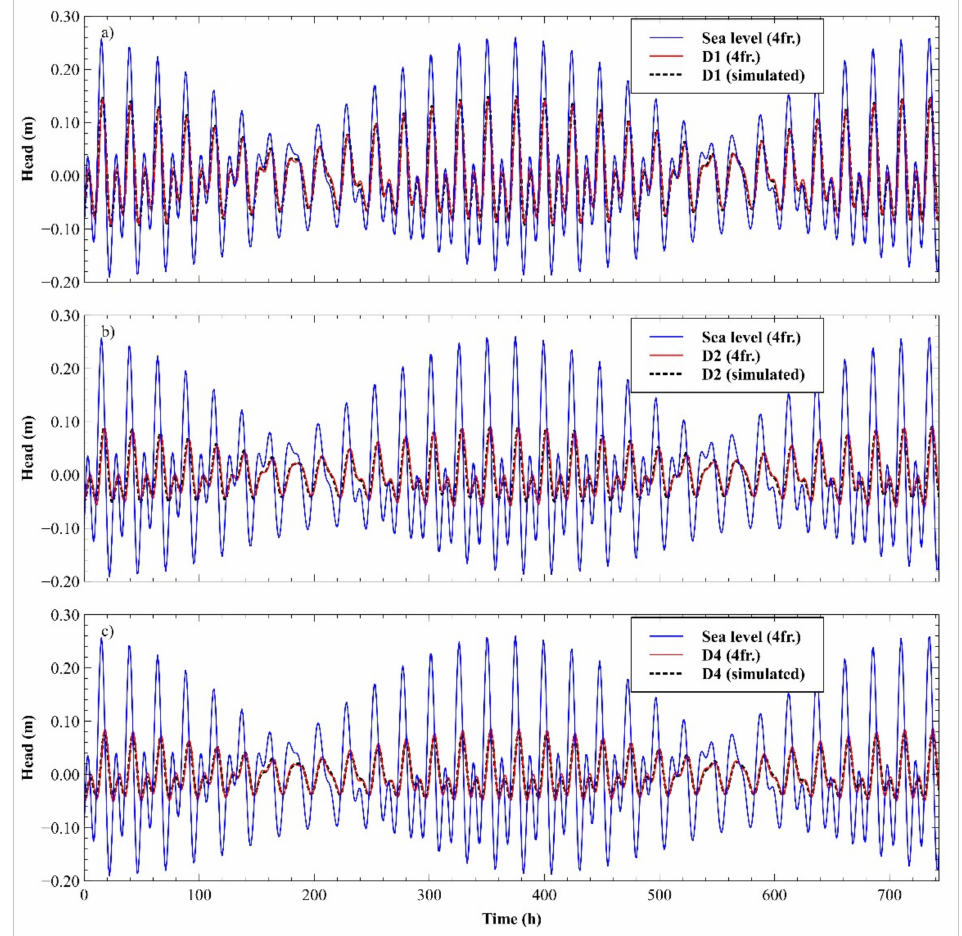
Figure 9. Verification of hydrogeological parameter values obtained for D1 during the period of 1 August to 31 August 2015 by application to the period 1 July to 31 July 2015; ( a ) D1 piezometer, ( b ) D2 piezometer, and ( c ) D4